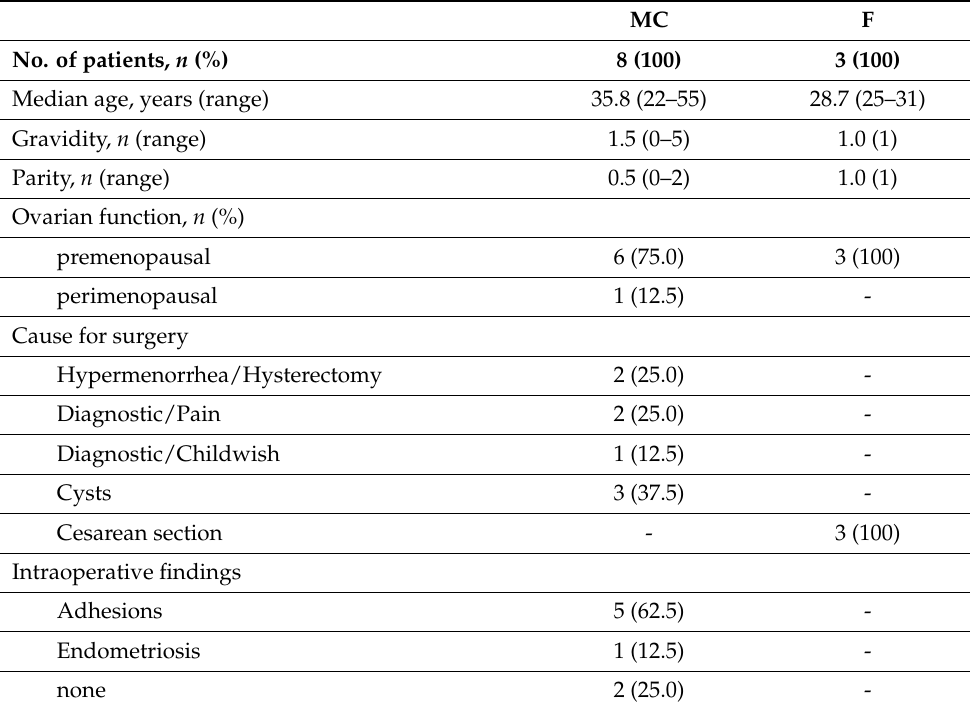
Table 2. Patient